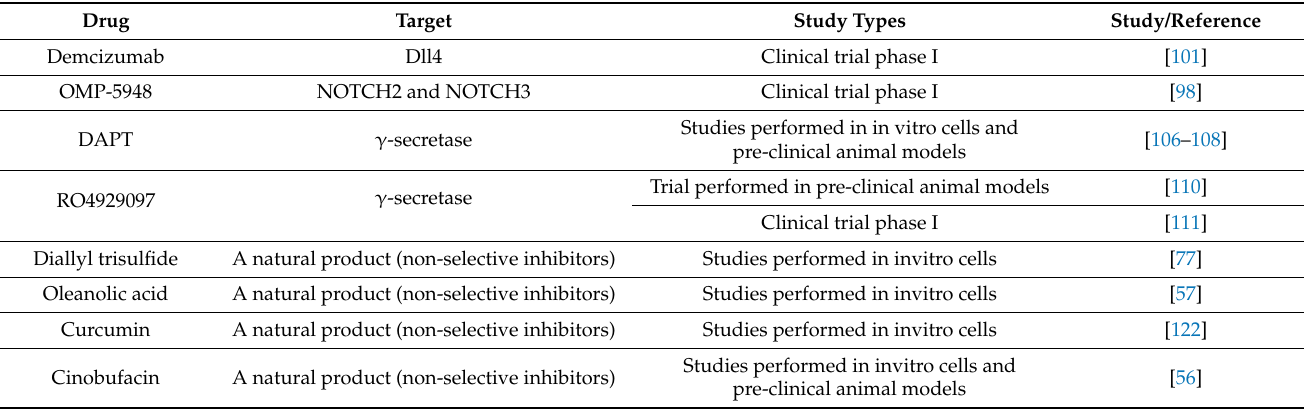
Table 2. Osteosarcoma treatment strategy based on NOTCH